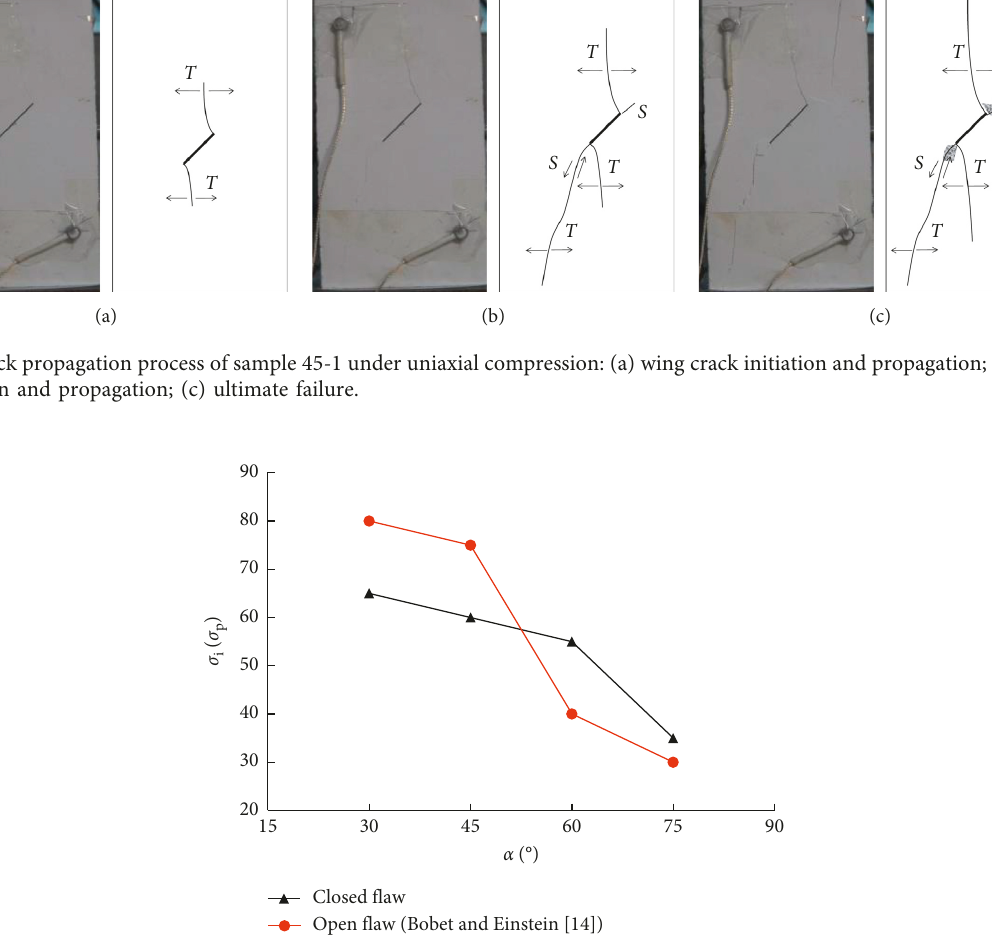
Figure 9: Influence of the flaw inclination angle on the wing crack initiation